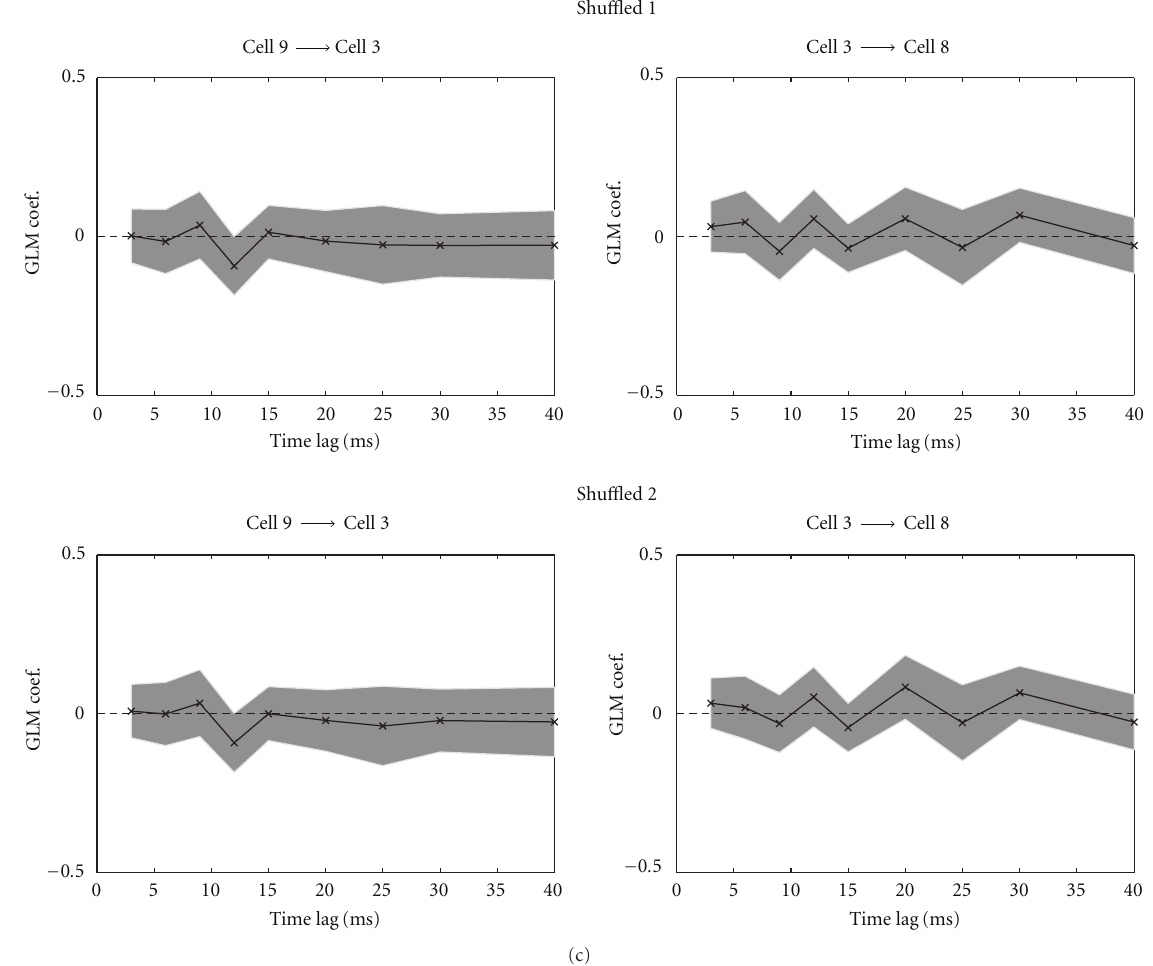
Figure 4: Two representative examples of estimated GLM coe ffi cients { α i , k } (shown in vertical axis, dimensionless) of cell pair interactions between unsuccessful and successful trials during reaching movement. Positive/negative coe ffi cients represent excitatory/inhibitory e ff ects. Notation c → d denotes the directional spiking dependence from trigger cell c to target cell d . The shaded areas around the curve indicate the 95% confidence intervals of the estimated coe ffi cients. Only those coe ffi cients whose 95% confidence intervals do not overlap with zero are identified as significant connections. In the two examples displayed (Dataset-1), the cells numbered 3, 8, and 9 were classified as two FS neurons and a RS neuron, respectively. (a) Estimated GLM coe ffi cients using complete (21 + 21) trials. (b) Estimated coe ffi cients averaged from 20 Monte Carlo runs using only half of (11+11) trials (shaded bars show the standard error of the mean). (c) Estimated GLM coe ffi cients averaged from 100 Monte Carlo runs using shu ffl ed successful/unsuccessful trial